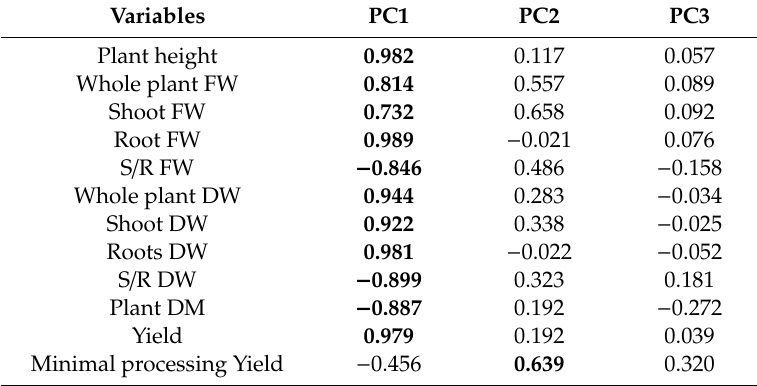
Table 9. Correlation of variables to the factors of the principal components analysis (PCA) based on factor